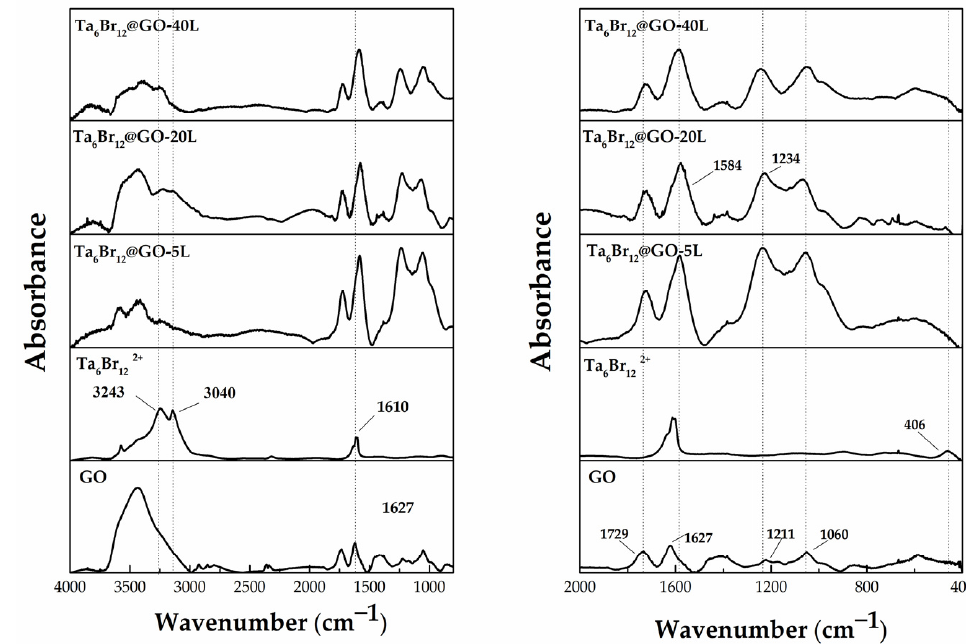
Figure 4. Two regions of the FTIR spectra of {Ta 6 Br i 12 }@GO, [{Ta 6 Br i 12 }Br a 2 (H 2 O) a 4 ] · 4H 2 O, and GO materials.